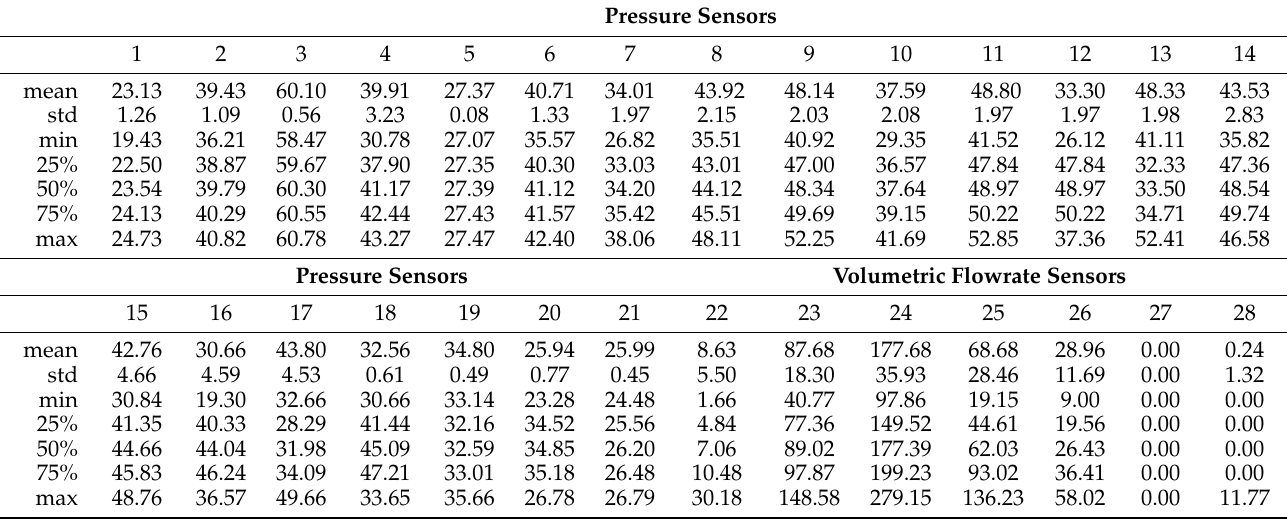
Table 2. Statistics of synthetic pressure sensors 1 to 21 and flowrate sensors 22 to 28 from chunk 697.